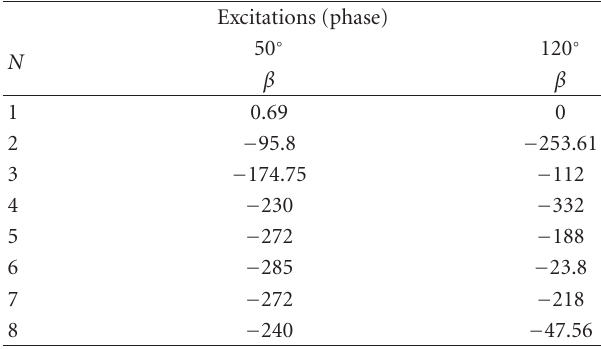
Table 1: Steering one